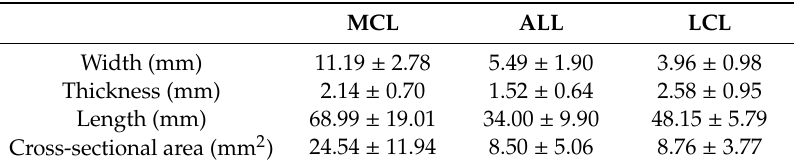
Table 2. Size measurement results of the